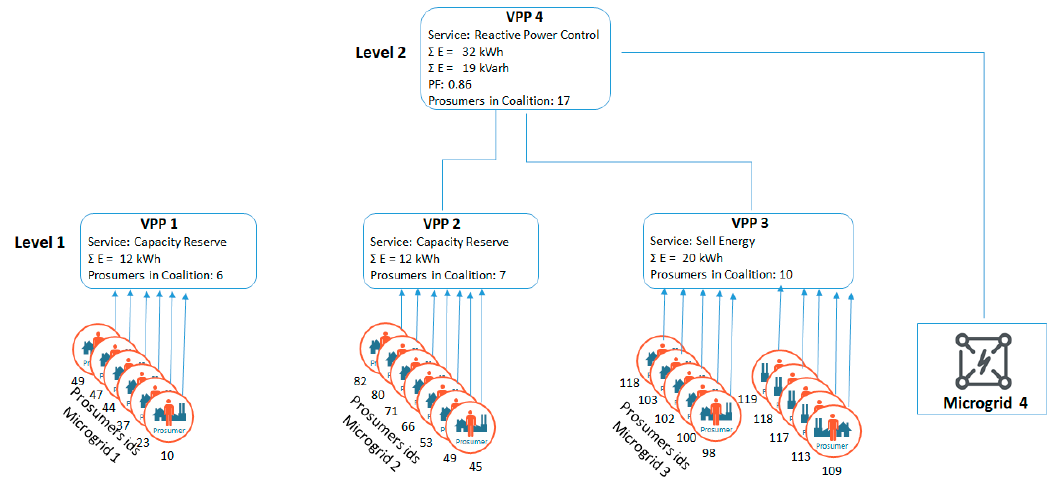
Figure 6. VPP hierarchy constructed using the proposed model.